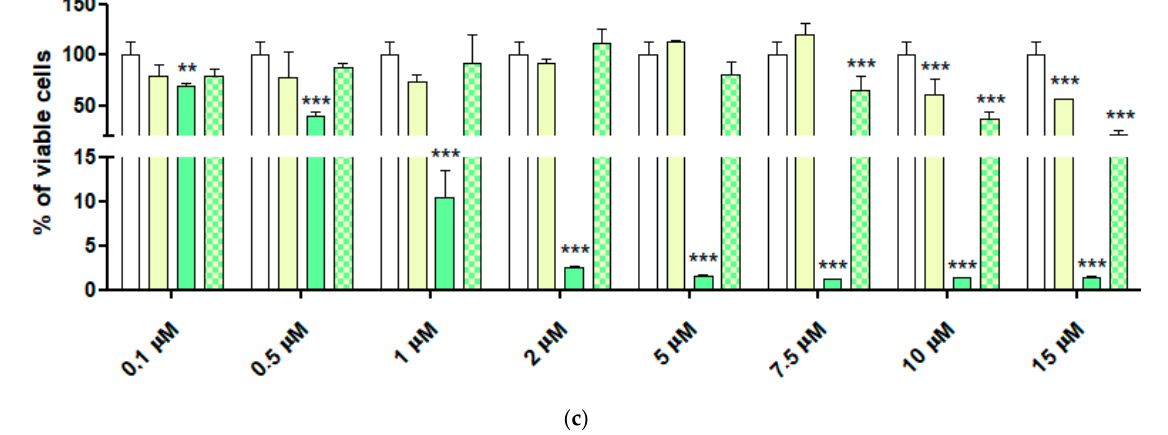
Figure 11. Dose- and time-dependent cytotoxicity activity of P5, 4-HPR, and 4-HPR-P5 NPs at 24 h ( a ), 48 h ( b ), and 72 h ( c ) in IMR-32 cells. Concentration values reported on the x-axis refer to 4-HPR, while the concentrations used for P5 and 4-HPR-P5 NPs can be derived from Table 2. White columns: control; yellow columns: P5; green columns: free 4-HPR; and checkered columns: 4-HPR-P5